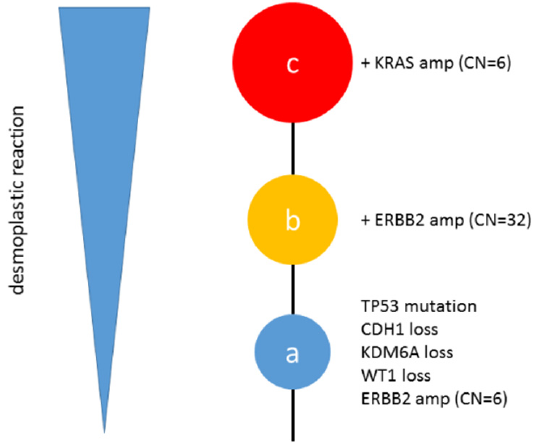
Figure 2. Phylogenetic tree summary. Phylogenetic tree for this tumor from region a to Figure 3. Phylogenetic tree summary. Phylogenetic tree for this tumor from region a to c.